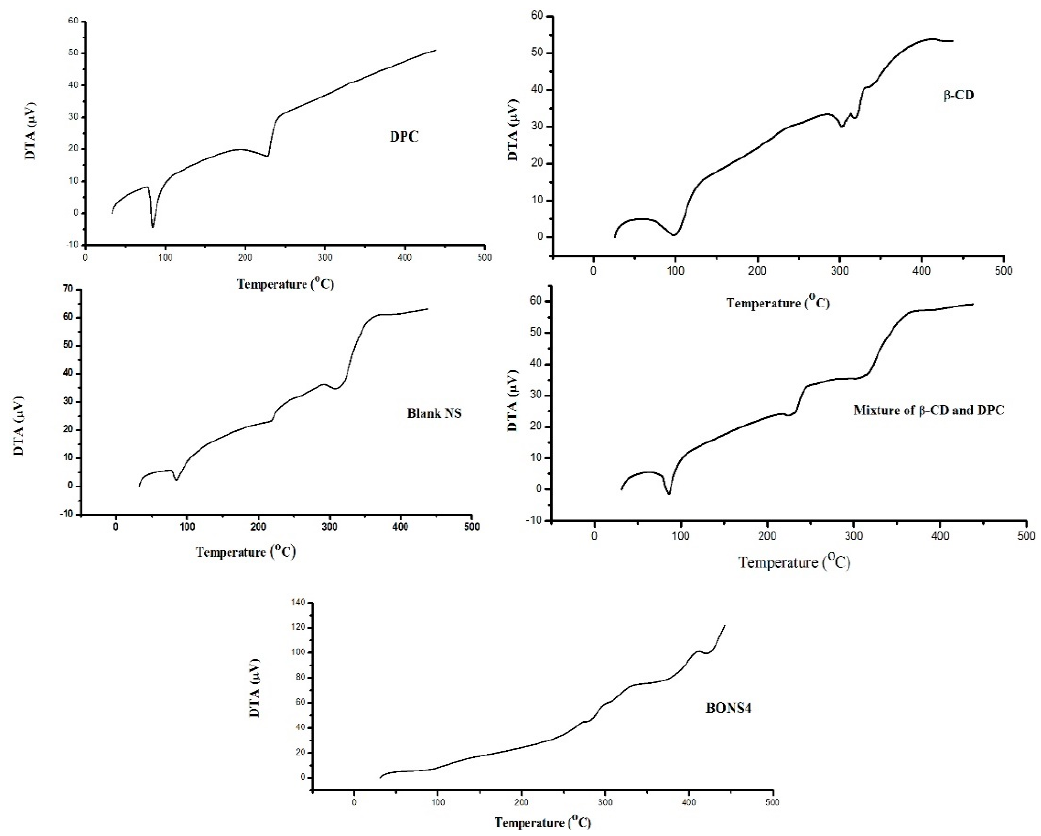
Figure 5. DTA curves of β -CD, DPC, blank NS, mixture of β -CD and DPC, and BONS4.